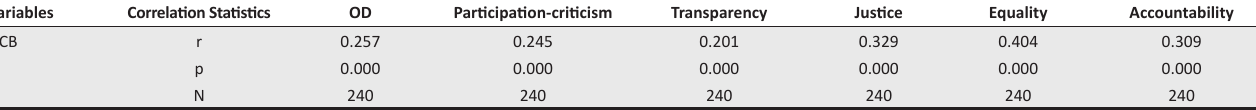
TABLE 4: Correlation analysis: Organisational democracy and organisational citizenship behaviour relationship. Variables Correlation